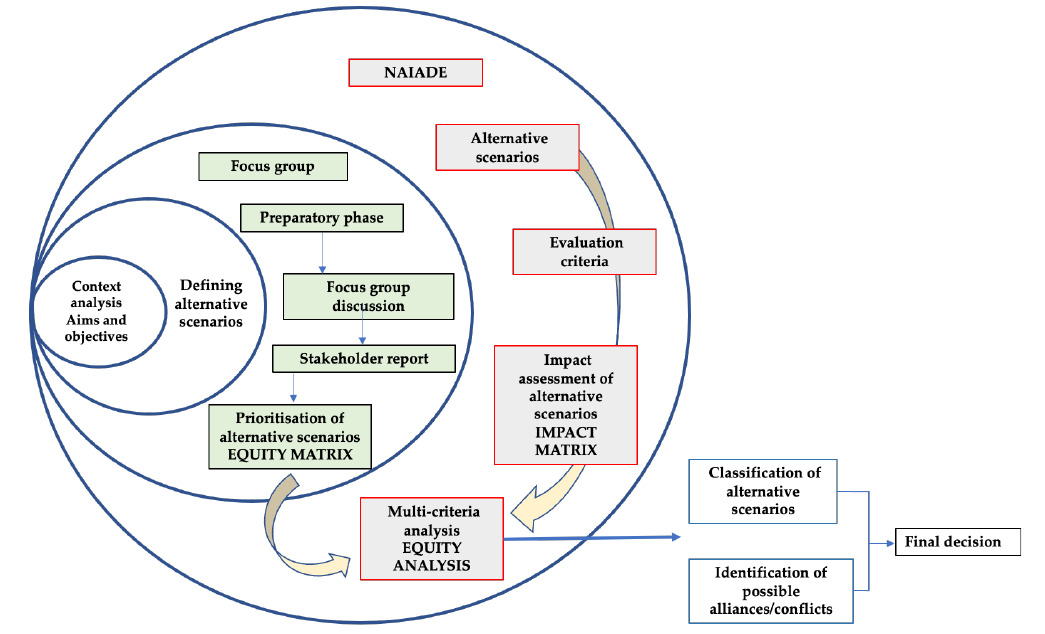
Figure 1. The proposed methodological